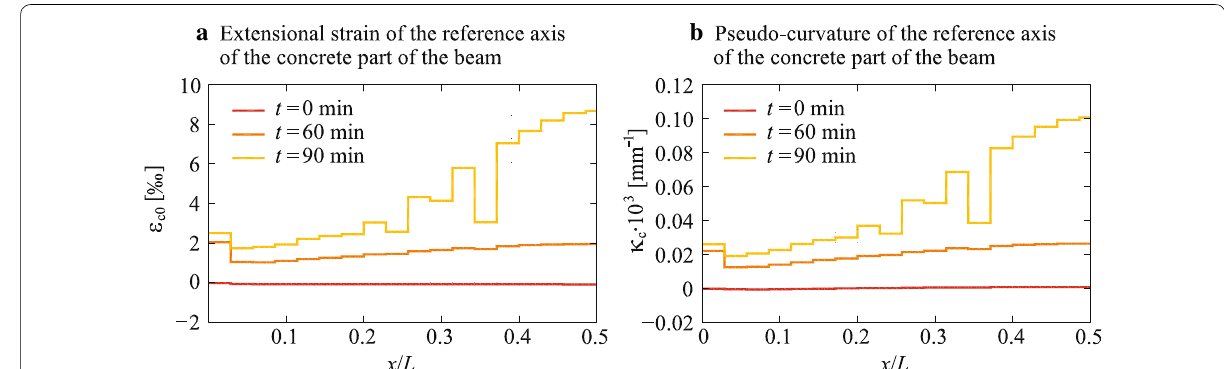
Fig. 15 The distributions of extensional strains and pseudo-curvature along the concrete part of the beam at different simulation